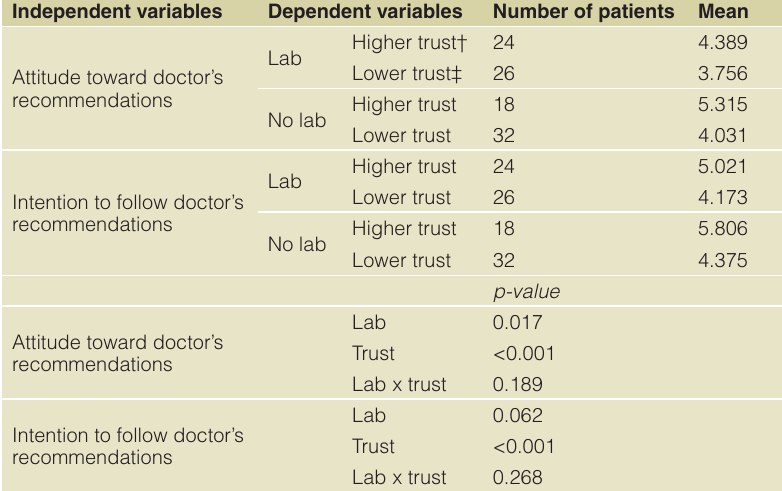
Table 3. Effects of the patient personality ‘trust toward doctors’: results of the two-way analysis of variance (Lab, the laboratory test group; No Lab, no laboratory test